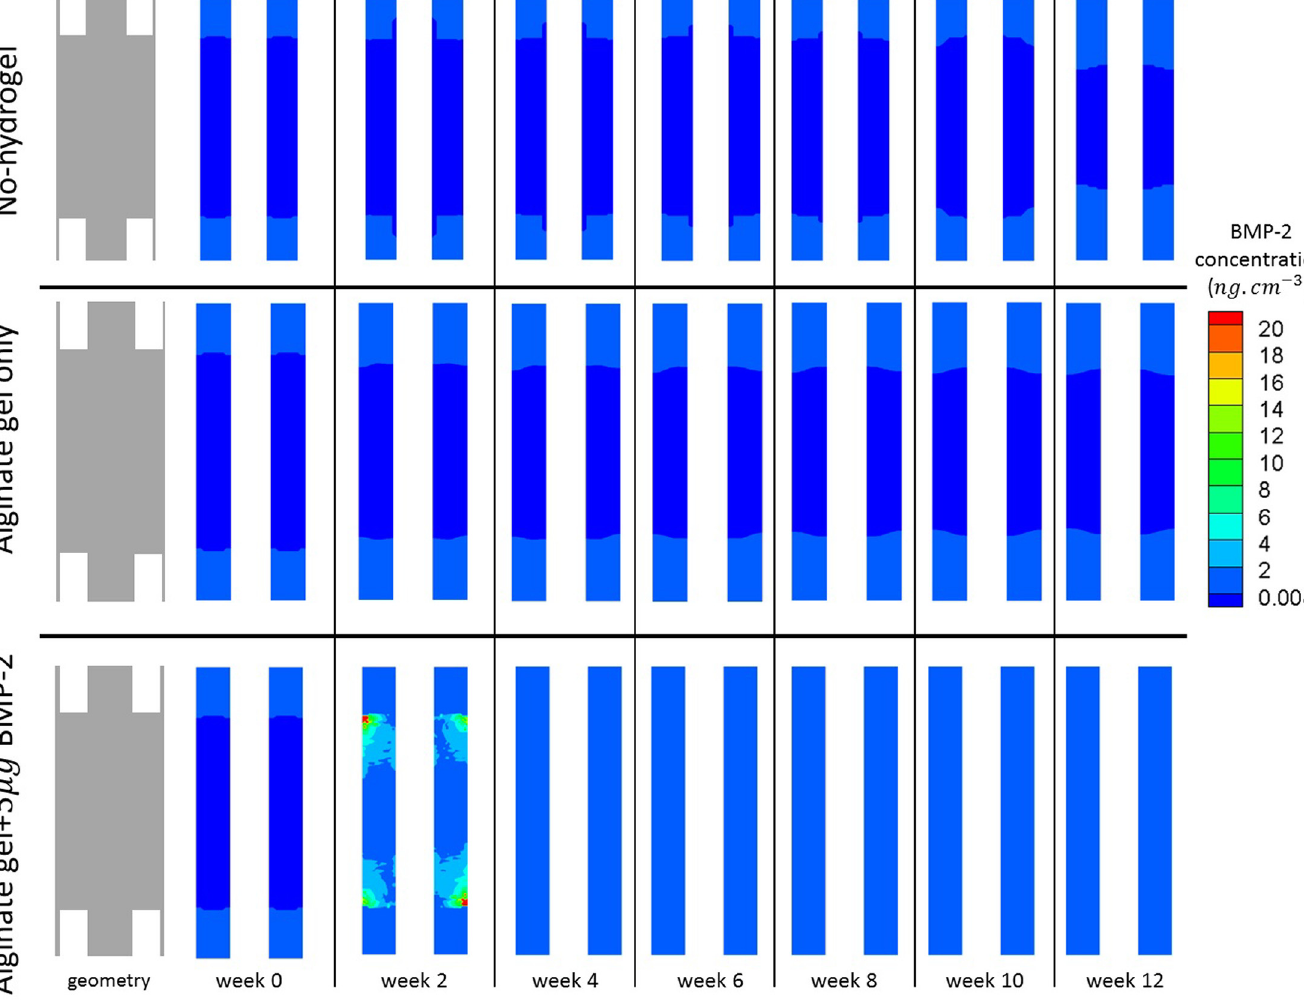
Fig 9. Evolution of BMP-2 concentration. Evolution of BMP-2 concentration inside the bone defect over 12 weeks, when: no hydrogel was placed inside the bone defect (top); an alginate hydrogel was placed inside the bone defect (middle), and an alginate hydrogel with 5 μ g of BMP-2 (bottom) was placed inside the bone